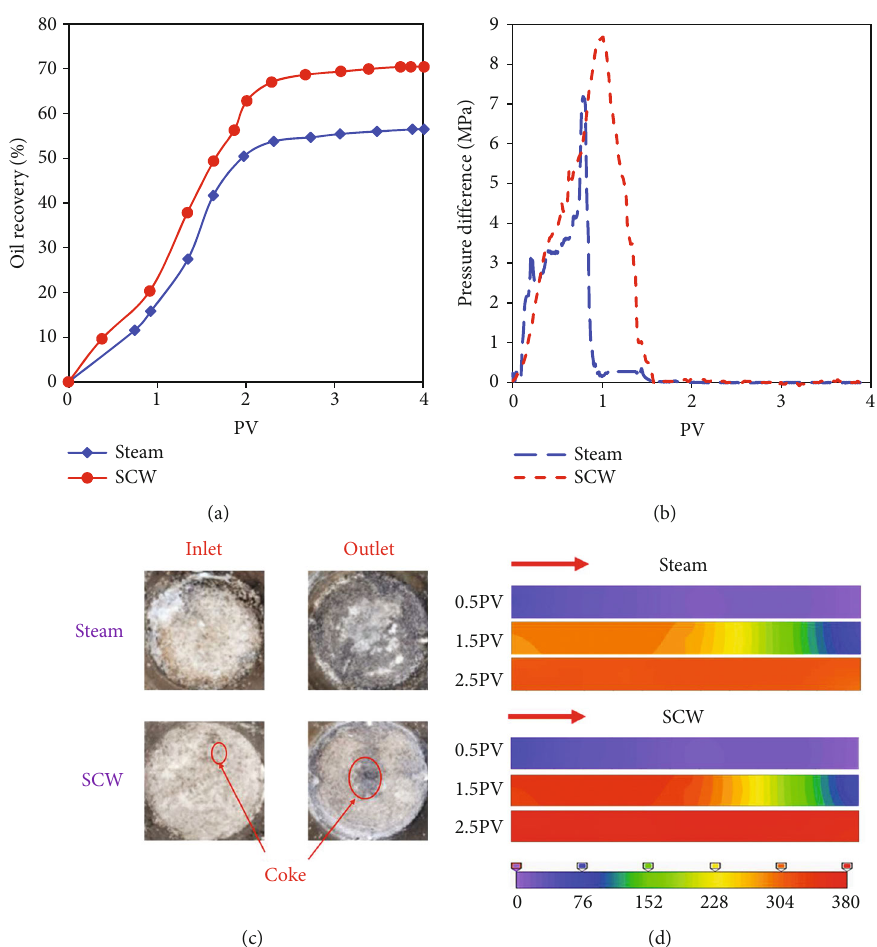
Figure 5: Experimental results of steam and SCW fl ooding: (a) oil recovery, (b) pressure di ff erence, (c) inlet and outlet cross-sections, and (d) temperature